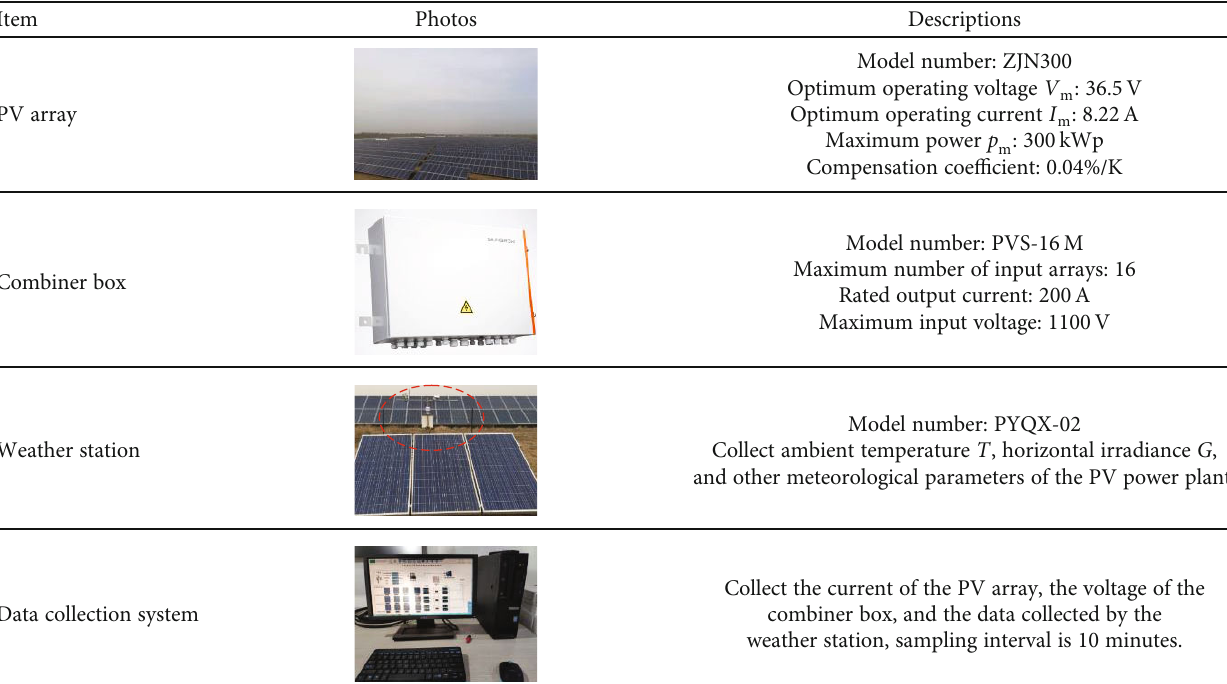
Table 1: Experimental platform.